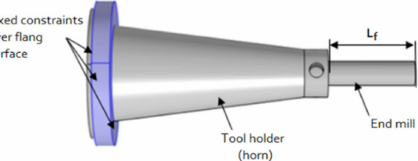
Figure 2. Tool holder with end mill tool geometrical model—rigid fix constraint boundary